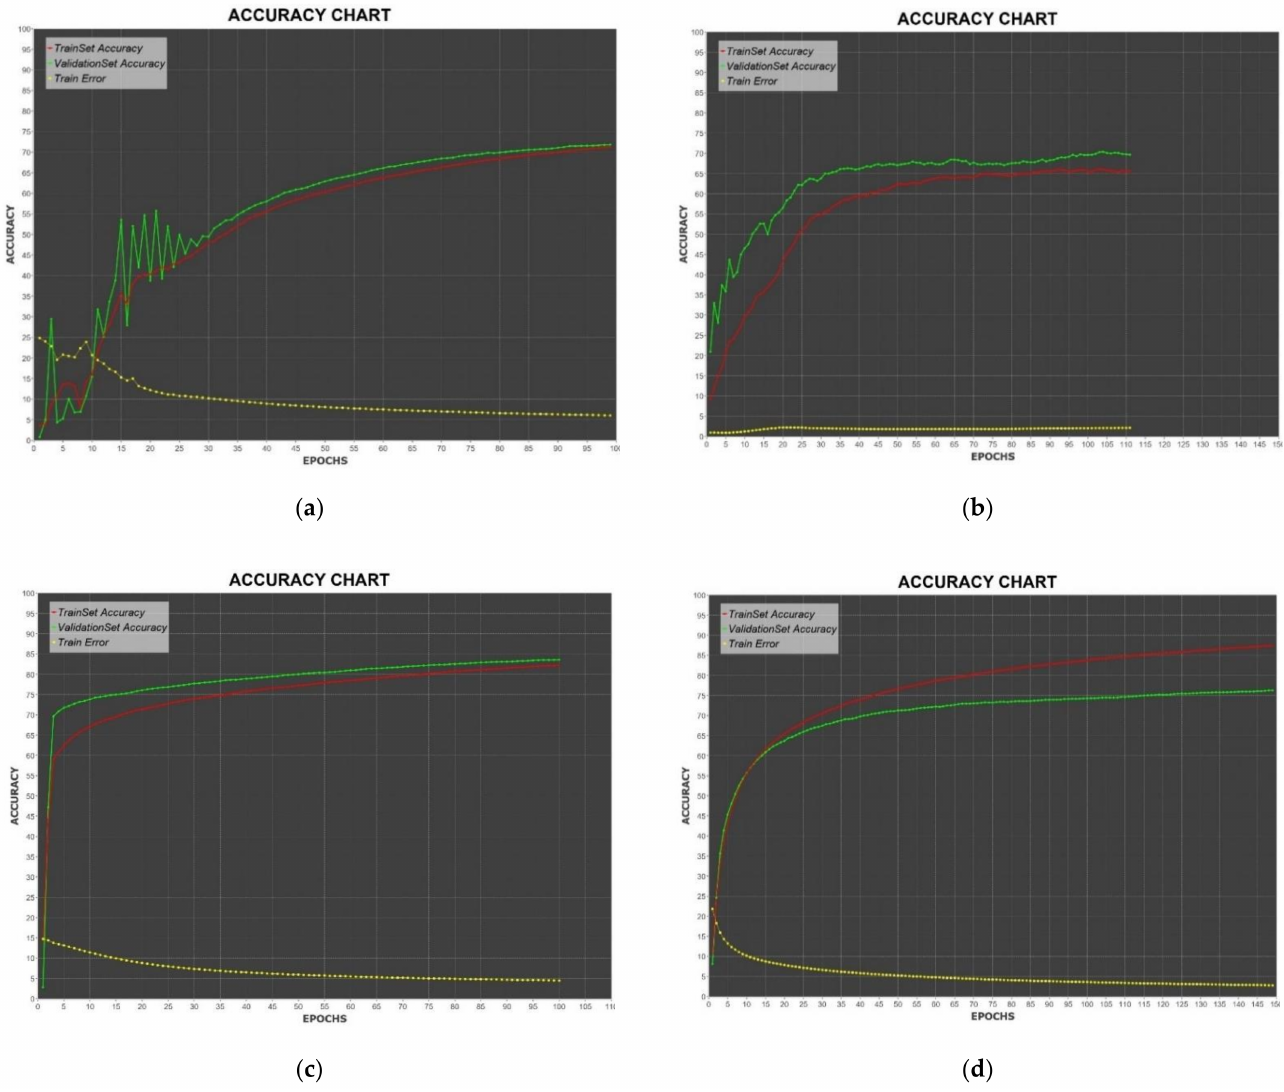
Figure 8. Impact of shuffled–unshuffled trainset: ( a ) unshuffled trainset, backpropagation, full batch; ( b ) unshuffled trainset, backpropagation, batch = 1; ( c ) shuffled trainset, backpropagation, full batch; ( d ) shuffled trainset, backpropagation, batch =